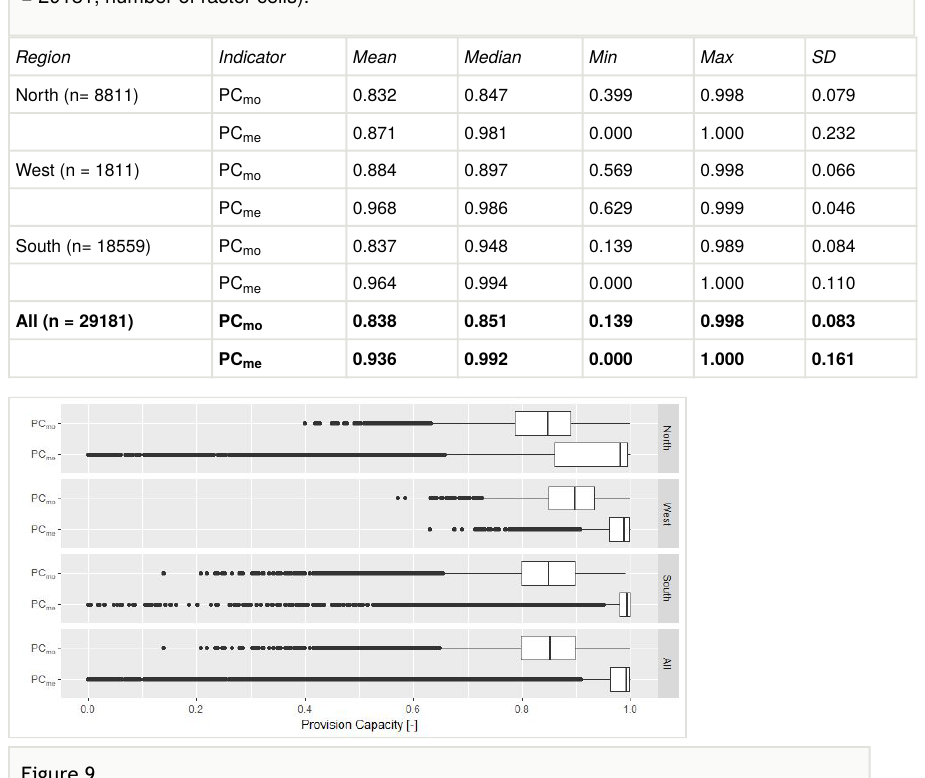
Boxplots for the indicators representing the provision capacity (PC : based on modelled actual soil loss data, PC : based on measured actual soil loss data), grouped by regions [-] (n = 29181, number of raster